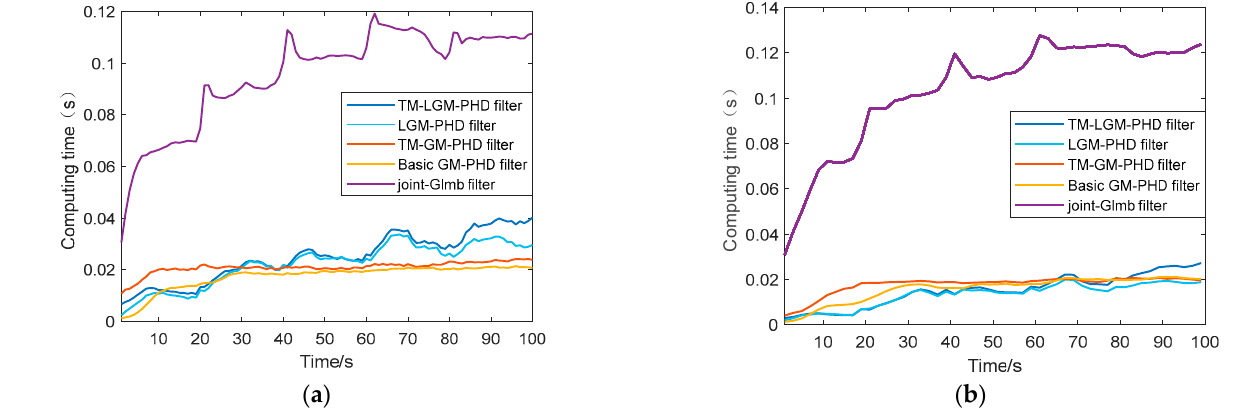
Figure 14. Computation time of different filters for 100 sample runs at T s = 1 s ( T i = 2 ms, λ = 104, p D , k = 0.8) ( a ) and T s = 2 s ( T i = 4 ms, λ = 52, p D , k = 0.96) ( b ) in example 2 (CA motion